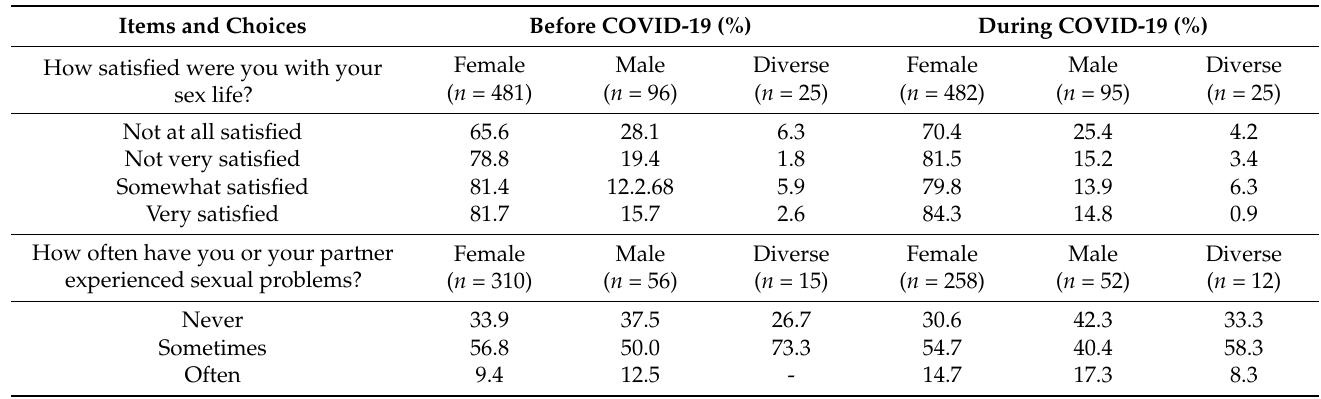
Table 3. Sexual satisfaction and sexual Problems, before and during COVID-19 social distancing measures, by participant